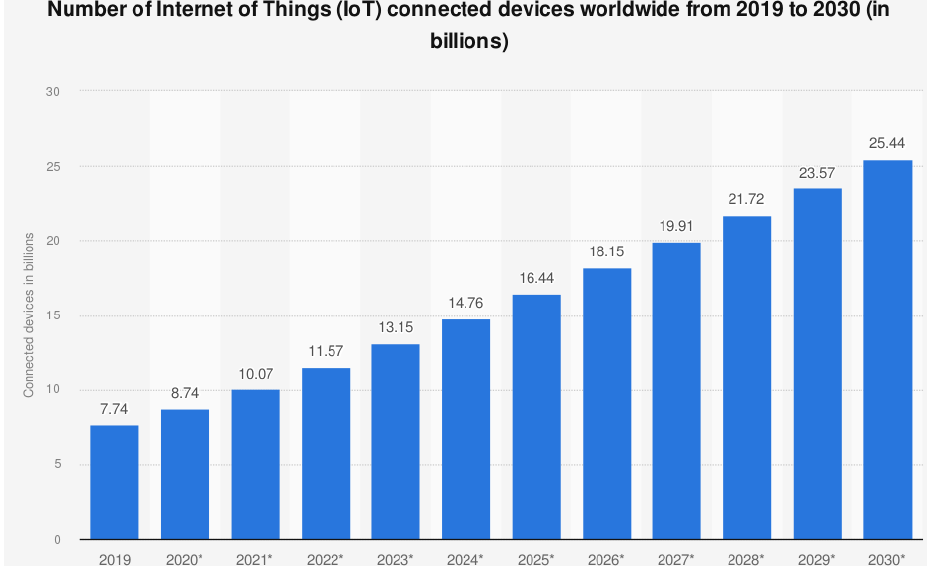
Figure 1. Internet of Things (IoT) devices installation growth trend [1]. Asteriks means projection